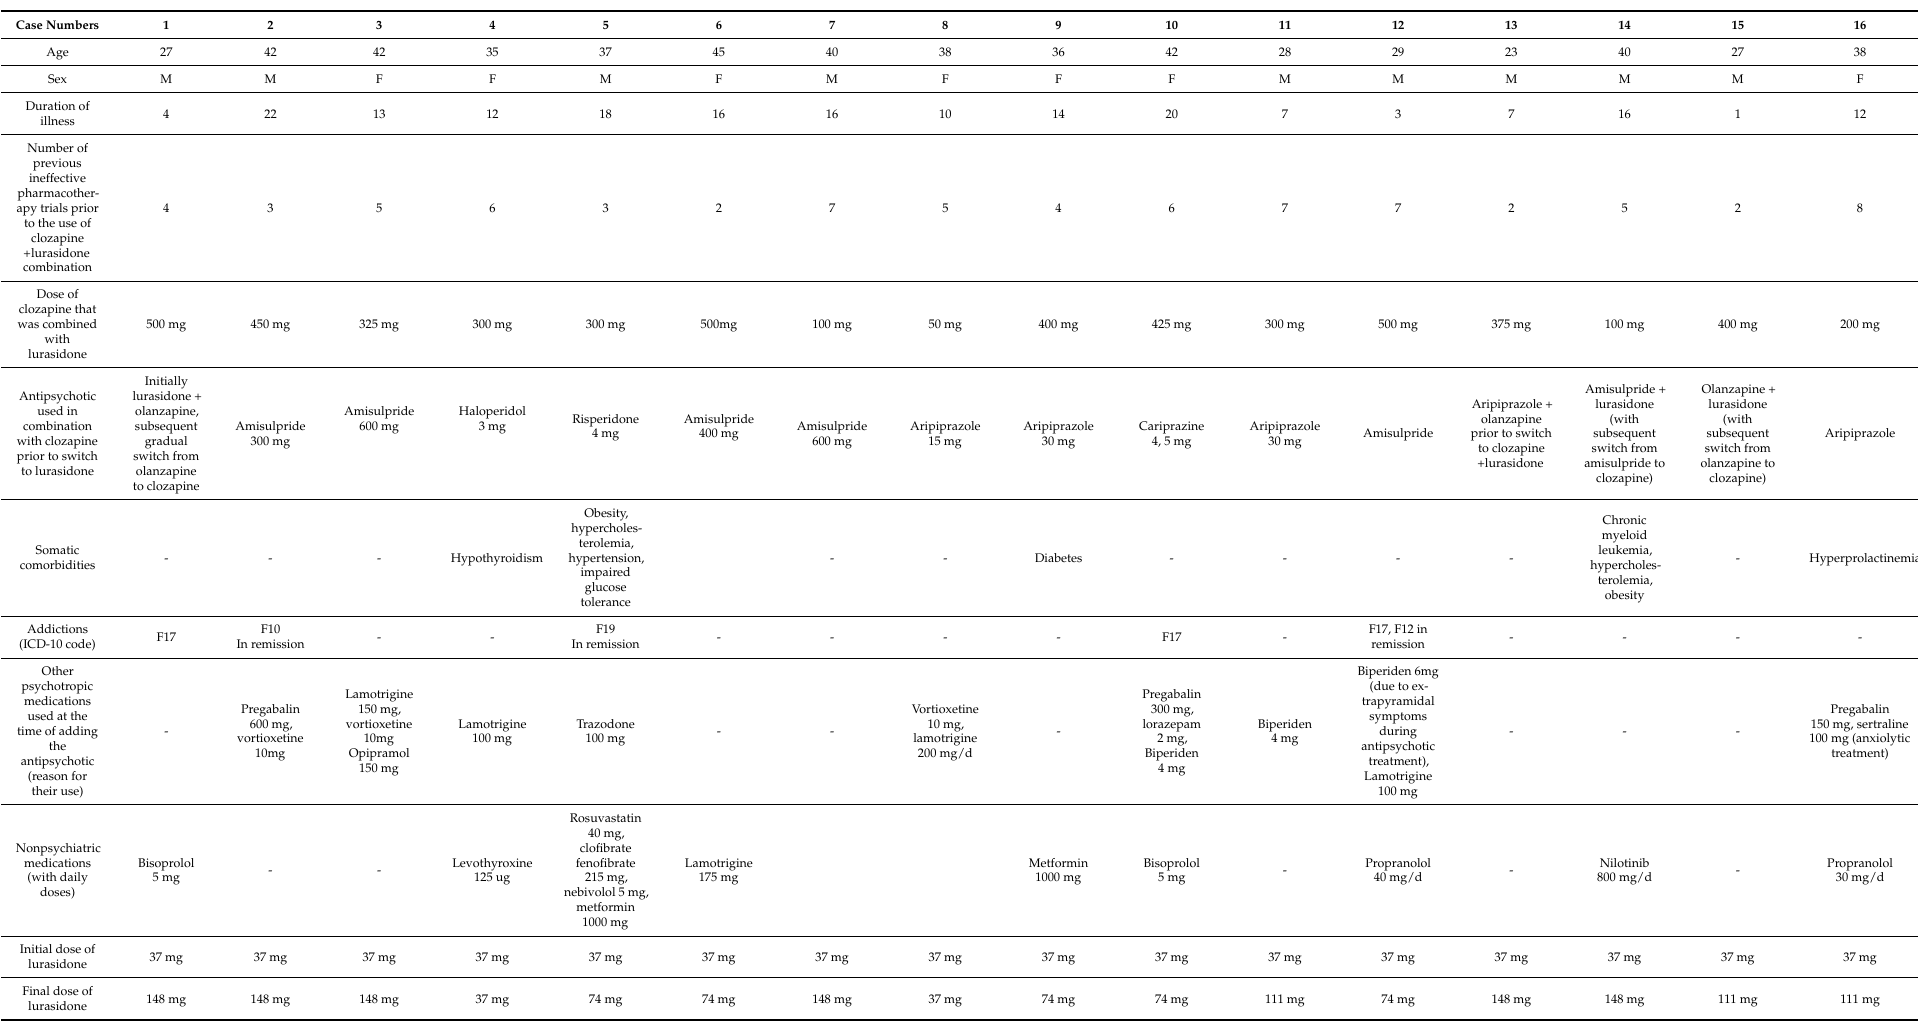
Table 1. Detailed description of schizophrenia patients treated with lurasidone augmentation of clozapine. The table has been attached as a separate file to make it easier to view, Table S1.